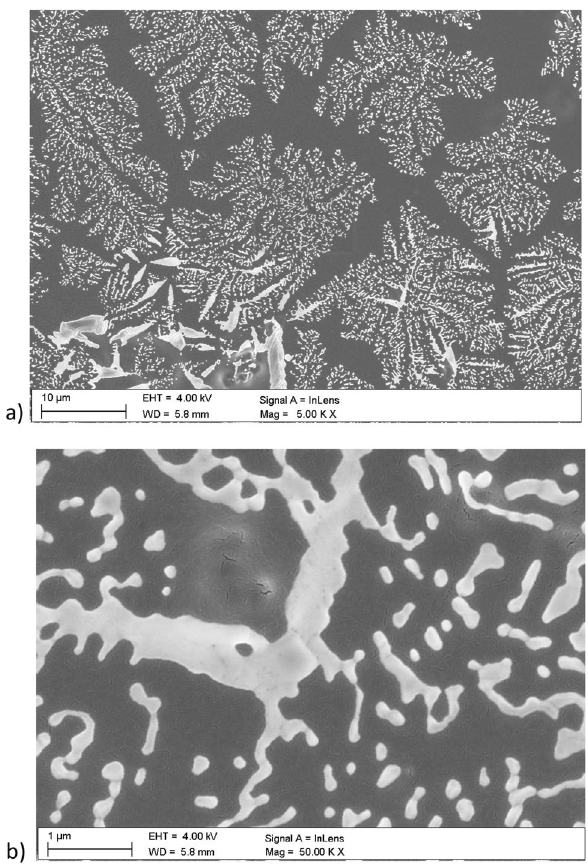
Figure 12. The Nb 2 O 5 “snowflakes” in surface of PMMA/Nb 2 O 5 composite film with 10% nanoparticles content ( a ). The fragment of “snowflakes” ( b